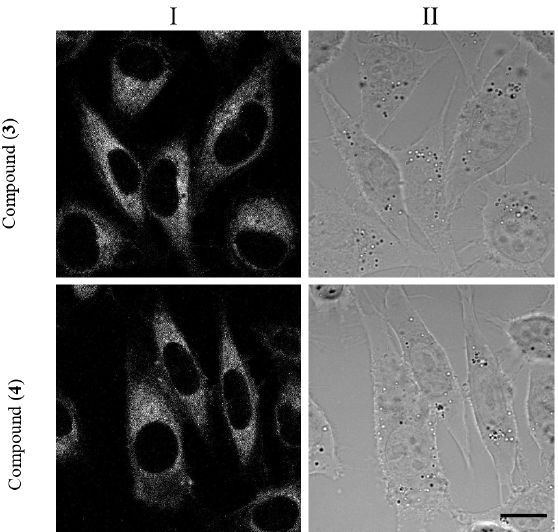
Figure 6. Intracellular distributions of chlorin p 6 thioanhydride ( 3 ) and chlorin p 6 selenoanhydride ( 4 ) in S37 cells. Column I: confocal fluorescence images describing the subcellular distribution. Column II: transmitted light images of the cells. Bar represents 10 µ m. Cells were incubated with chlorin p 6 thioanhydride ( 3 ) or chlorin p 6 selenoanhydride ( 4 ) (1 µ mol L − 1 ) for 2